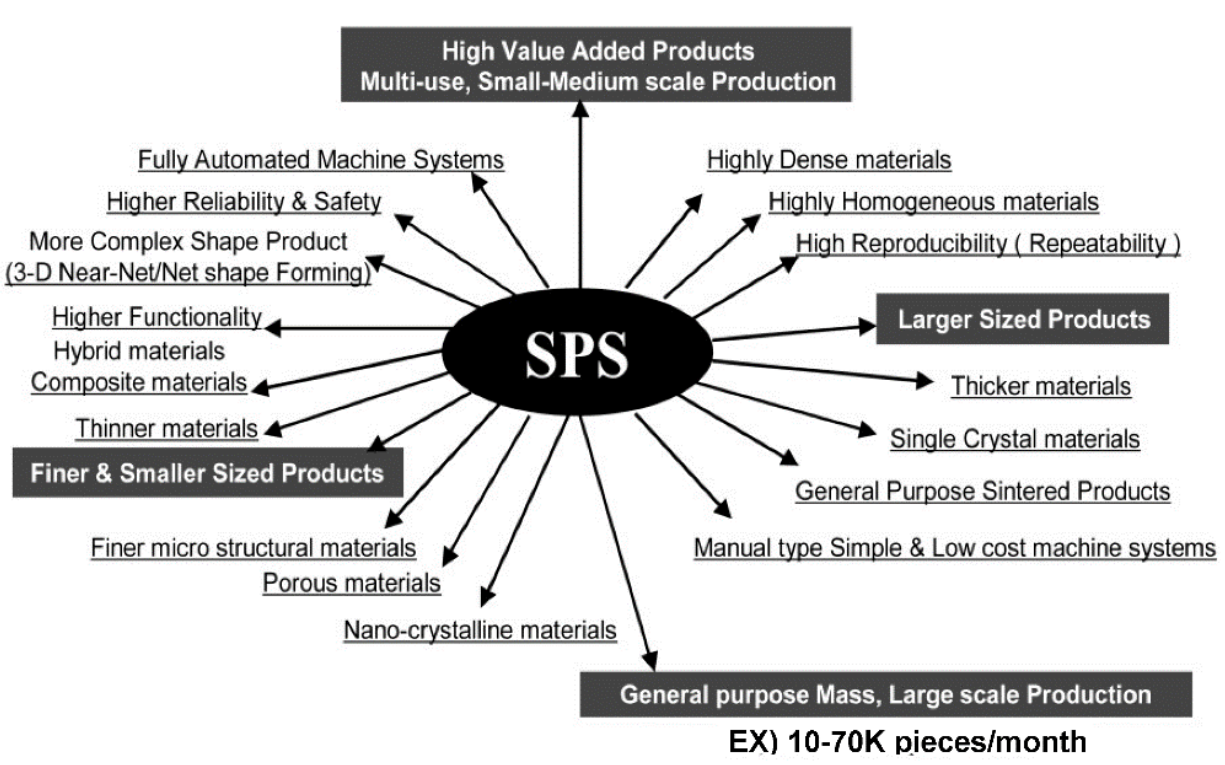
Figure 50. Recent demands on SPS technology from industries.